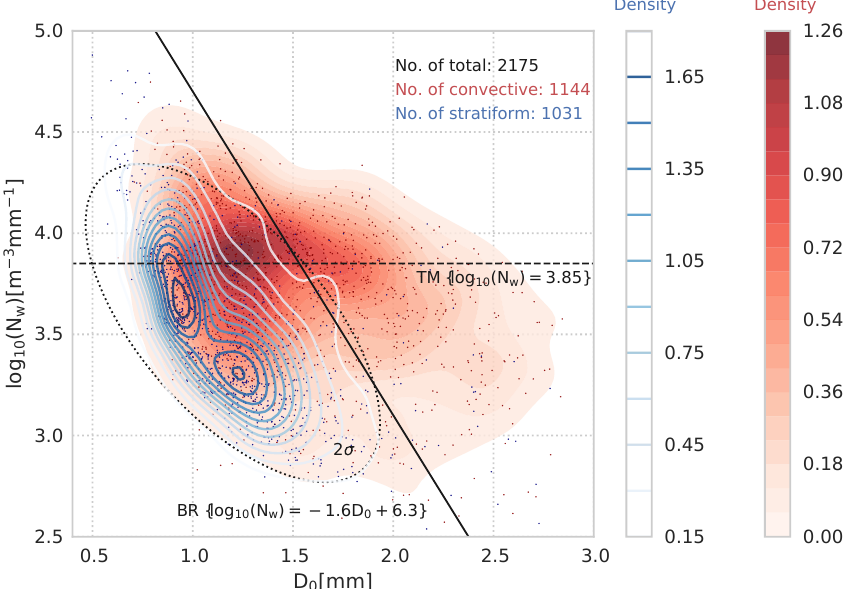
Figure 7. Scatter plot of log 10 ( N w ) versus D 0 from PARSIVEL disdrometer, overlaid by the contours representing the RWP-based classifi- cations for convective (red colors) and stratiform (blue lines) precipitating columns. The ellipse conveys the two-sigma confidence interval (dotted line) for those regions containing RWP-based stratiform DSDs. The convective–stratiform regime segregation concepts in Bringi et al. (2003, BR) and in Thompson et al. (2015, TM) are presented as a solid black line and dashed black line,